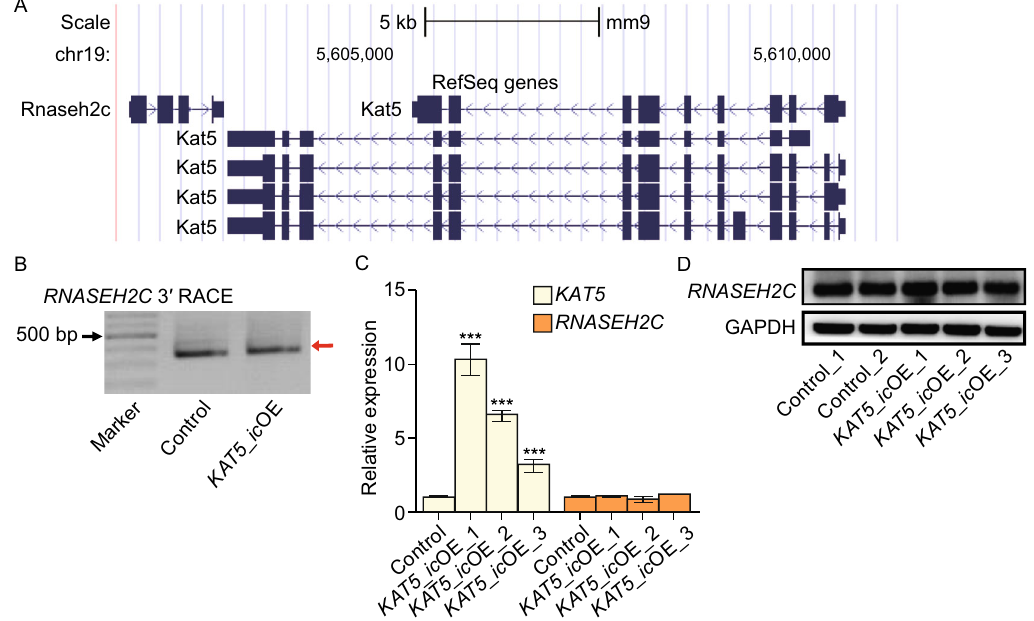
Figure 6. Overlapping pA site is required for antisense transcription mediated downregulation of protein production. (A) Gene structures of RNASEH2C and KAT5 based on mouse RefSeq gene annotation in UCSC genome browser. (B) 3 ′ RACE results for RNASEH2C in mouse NIH3T3 cells with or without KAT5 in cis over-expression ( KAT5_ic OE). (C) Relative expression of KAT5 and RNASEH2C in KAT5_ic OE and control mouse cells, quanti fi ed by qRT-PCR. (D) Western blot for RNASEH2C in KAT5_ic OE and control mouse cells. GAPDH served as the internal control. All the results showed in this fi gure were from single-